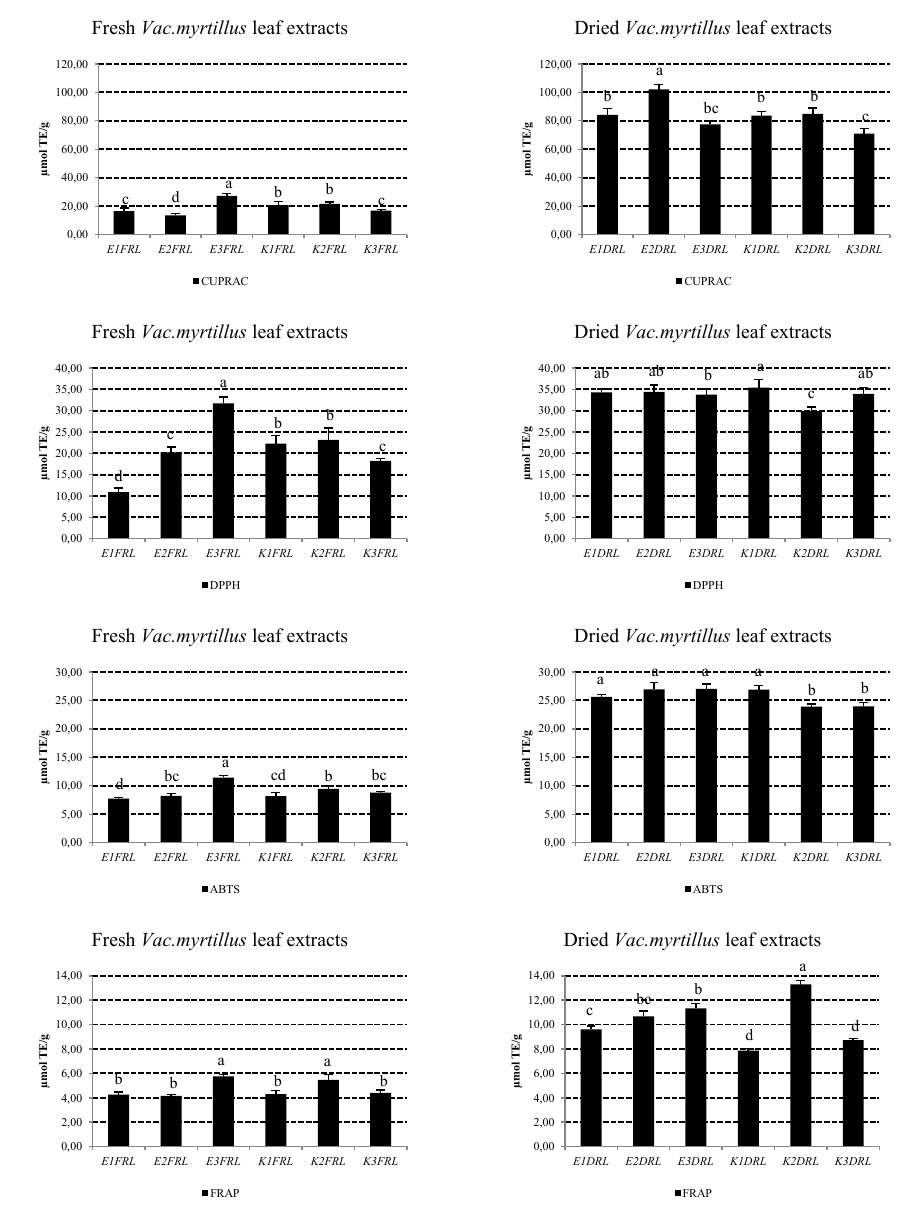
Fig. 4: Antioxidant capacities (μmol TE/g) of fresh and dried Vac. myrtillus leaf extracts (E: Erdek, K. Kapıdağ, FR: Fresh, DR: Dried, L: Leaf, 1-3: Codes of samples collected from different regions, Different letter(s) on bar indicate statistically significant differences, p <0.05)